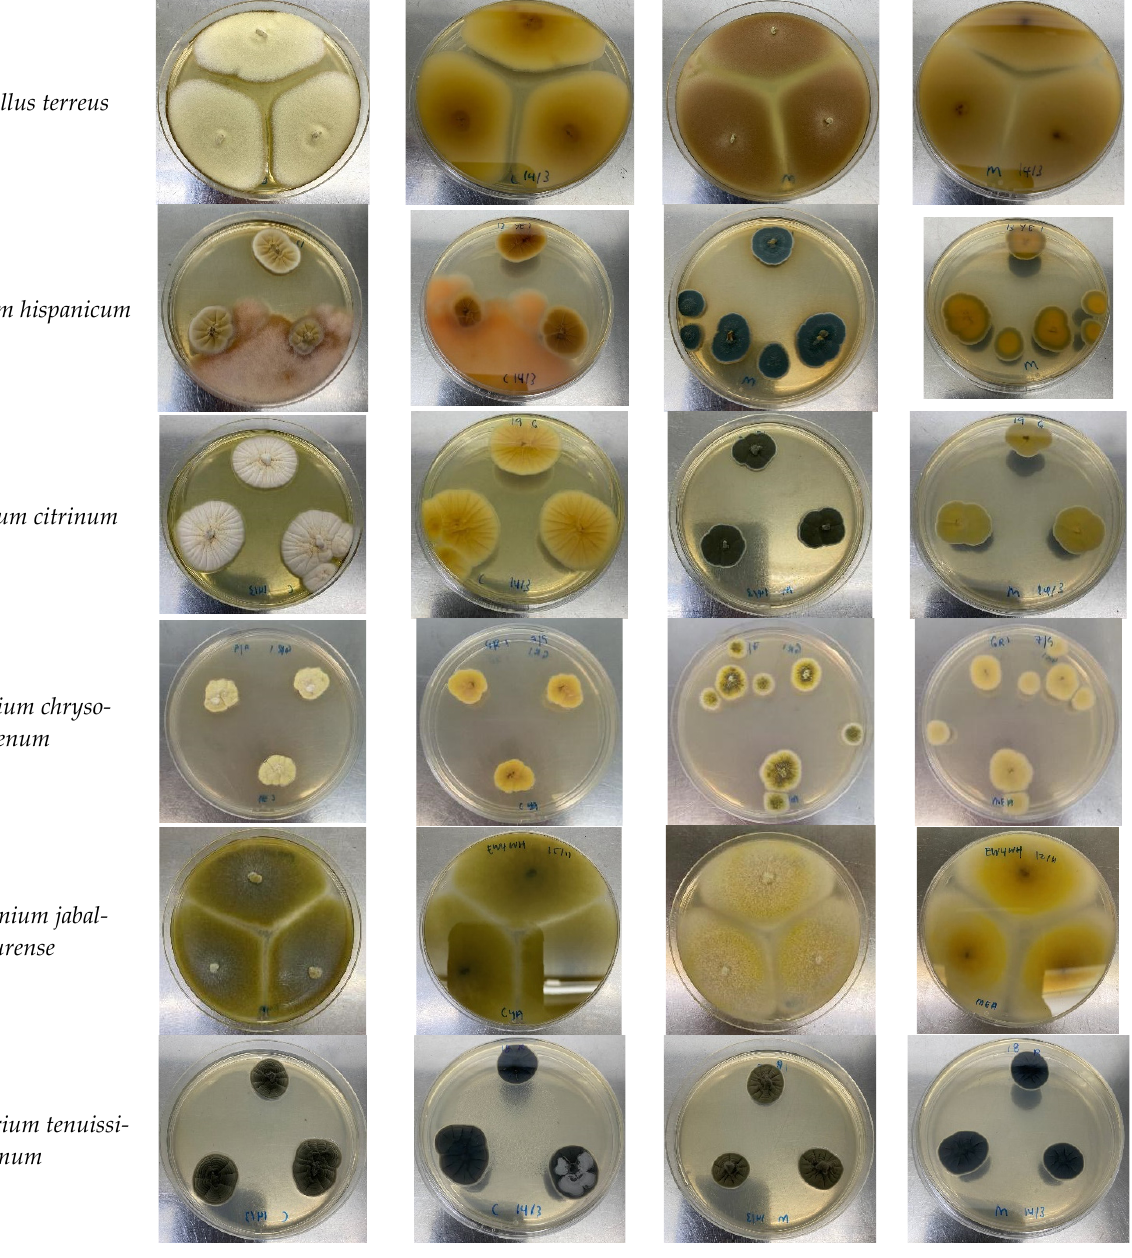
Figure 1. Morphological characteristics of fungal isolates on CYA and MEA after 5–7 days incubation. Table 3. Fungal identification based on the ITS region and detection of AF and OTA in the representative fungal isolates.